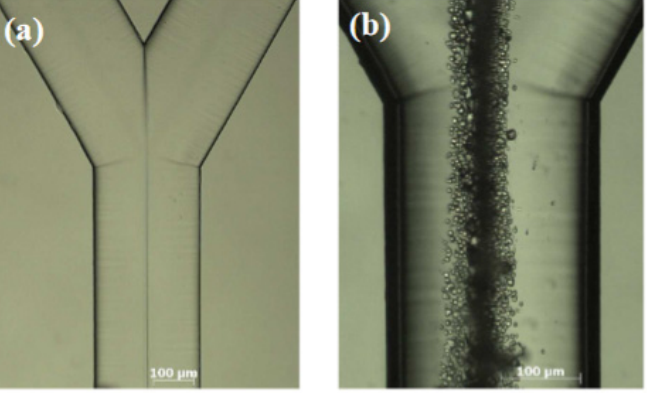
Figure 2. ( a ) Interfaces between the salt solutions in laminar flow and ( b ) CaCO 3 formation at the interface of the salts. Image reproduced from Youpeng Zeng et al., with permission from Cryst. Growth Des. [32] .